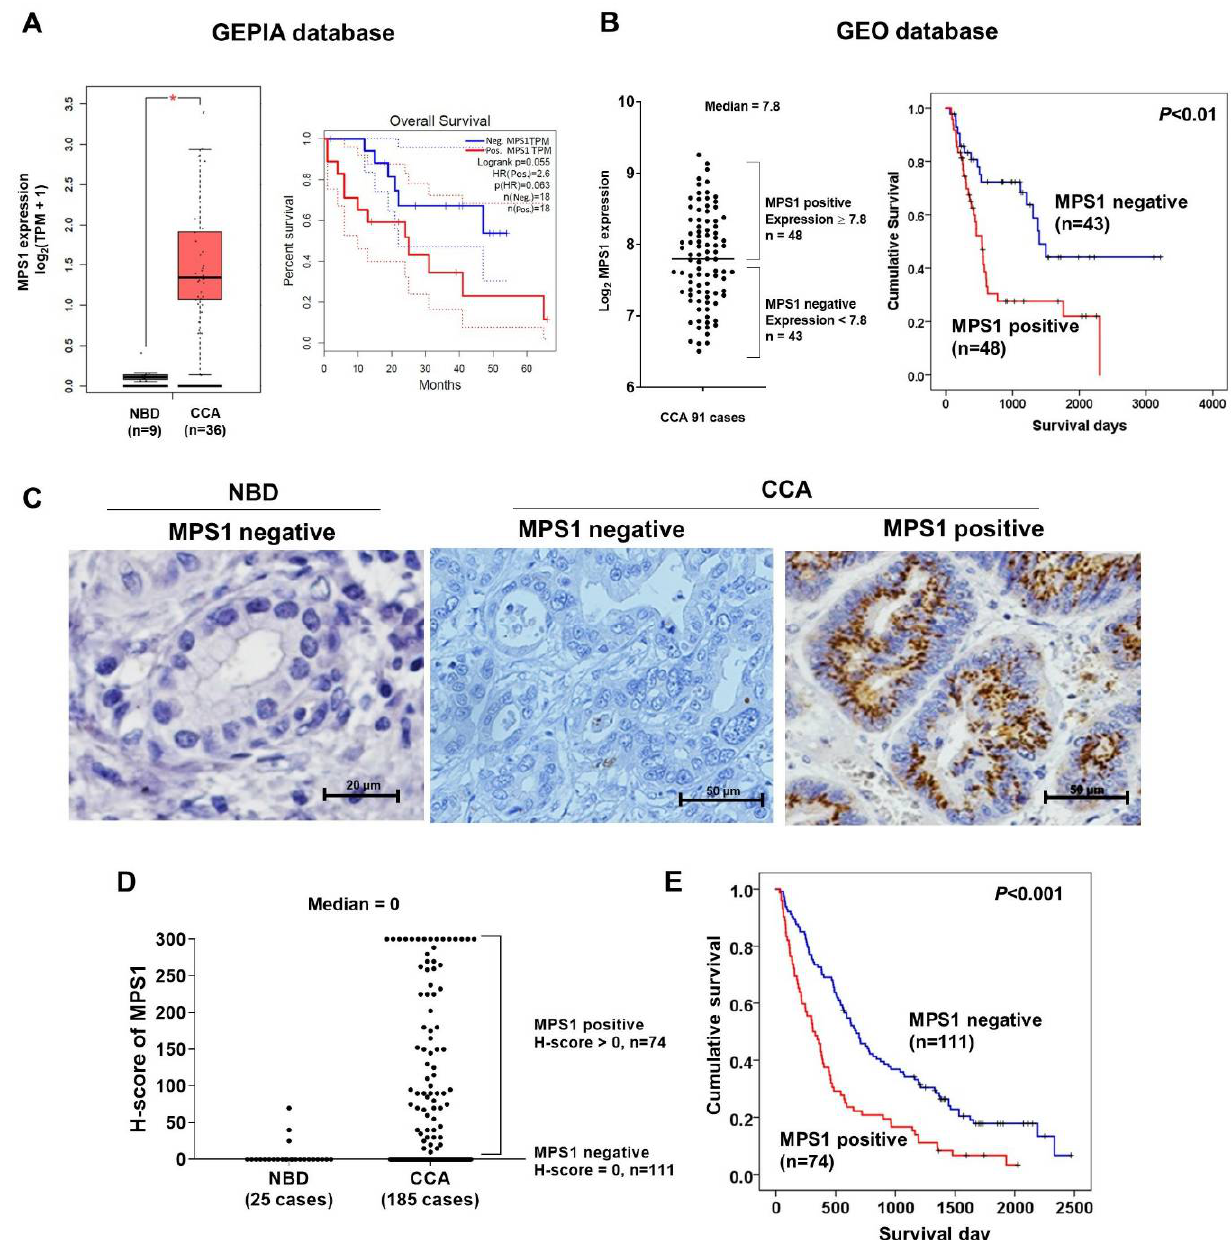
Figure 2. Overexpression of MPS1 or TTK in human CCA tissues. ( A ) A box plot of MPS1 transcript level in 36 human CCA tissues compared to 9 normal bile ducts (NBD). Comparison of overall survival curves between negative and positive MPS1 expressing patients. Data were retrieved from GEPIA database. TPM is transcript per million. * p < 0.05. ( B ) A dot plot of MPS1 transcript level in 91 human CCA patients categorized in two groups: MPS1 negative and MPS1 positive, using the median value of MPS1 expression (7.8). Cumulative survival times of MPS1 positive patients were significantly shorter than those of MPS1 negative patients ( p < 0.01). Data were retrieved from GEO database. ( C ) Representative IHC staining of MPS1 protein in 185 CCA patient tissues. MPS1 expression was not detected in NBD (magnification 400×) and MPS1 negative CCA tissues (magnification 200×). MPS1 positive CCA showed cytoplasmic staining of MPS1 (magnification 200×). ( D ) Distribution of MPS1 expression in 25 NBD and 185 CCA. Median H-score was 0, which was used as a cut-off value for dividing the MPS1 positive and negative cases. ( E ) Cumulative survival times of MPS1 positive patients (n = 74) were significantly shorter than those of MPS1 negative patients (n = 111) p < 0.001.